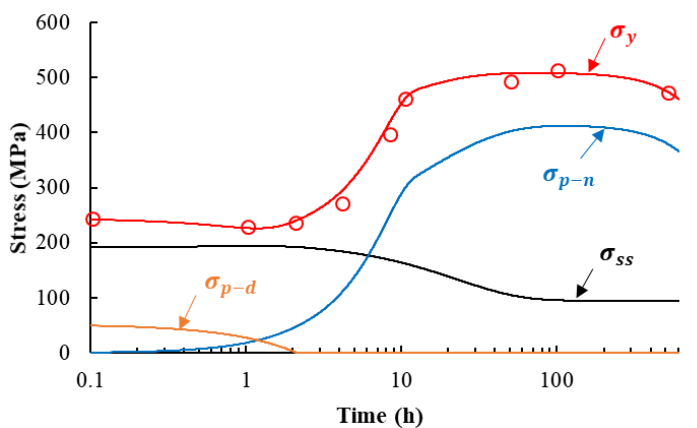
Figure 6. Comparison of evolutions of yield strength and corresponding strengthening components during artificial ageing of AA2198 at 155 °C from experiments (symbols [34]) and modelling results from Table 3 (lines).